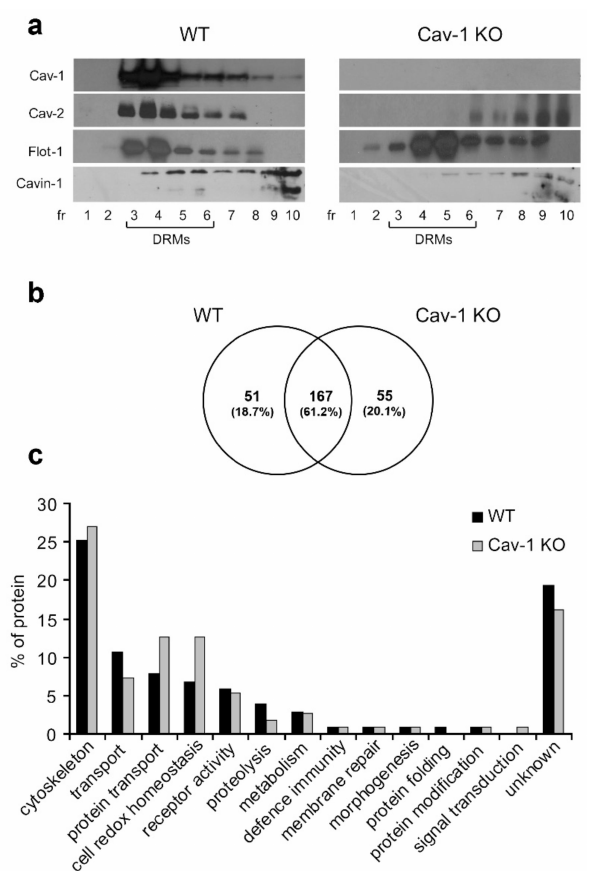
Figure 1. Characterization of detergent-resistant membranes (DRMs)-associated proteins. ( a ) Equal volumes of sucrose gradient fractions from lungs of wild-type (WT) and caveolin-1 knockout (Cav-1 KO) mice were subjected to western blot analyses for Cav-1, Cav-2, Flot-1, and Cavin-1. ( b ) Comparative analysis by reverse phase liquid chromatography-tandem mass spectrometry (RP-LC-MS / MS) of DRMs (pooled fractions 3–6). The Venn diagram shows the number of specific and common WT / Cav-1 KO proteins identified in at least two of the three independent biological replicates. ( c ) Classification of WT and KO DRM proteins into functional categories based on PANTHER